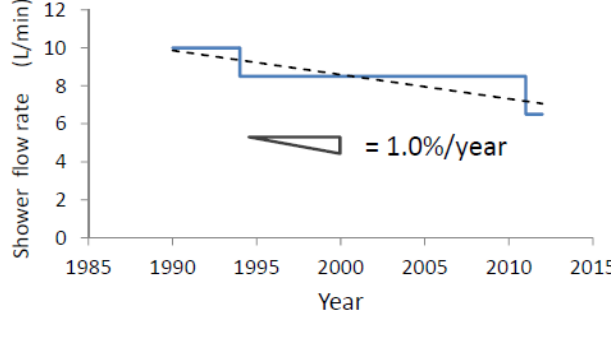
Figure 8. Eco-efficiency improvement rate, α , of